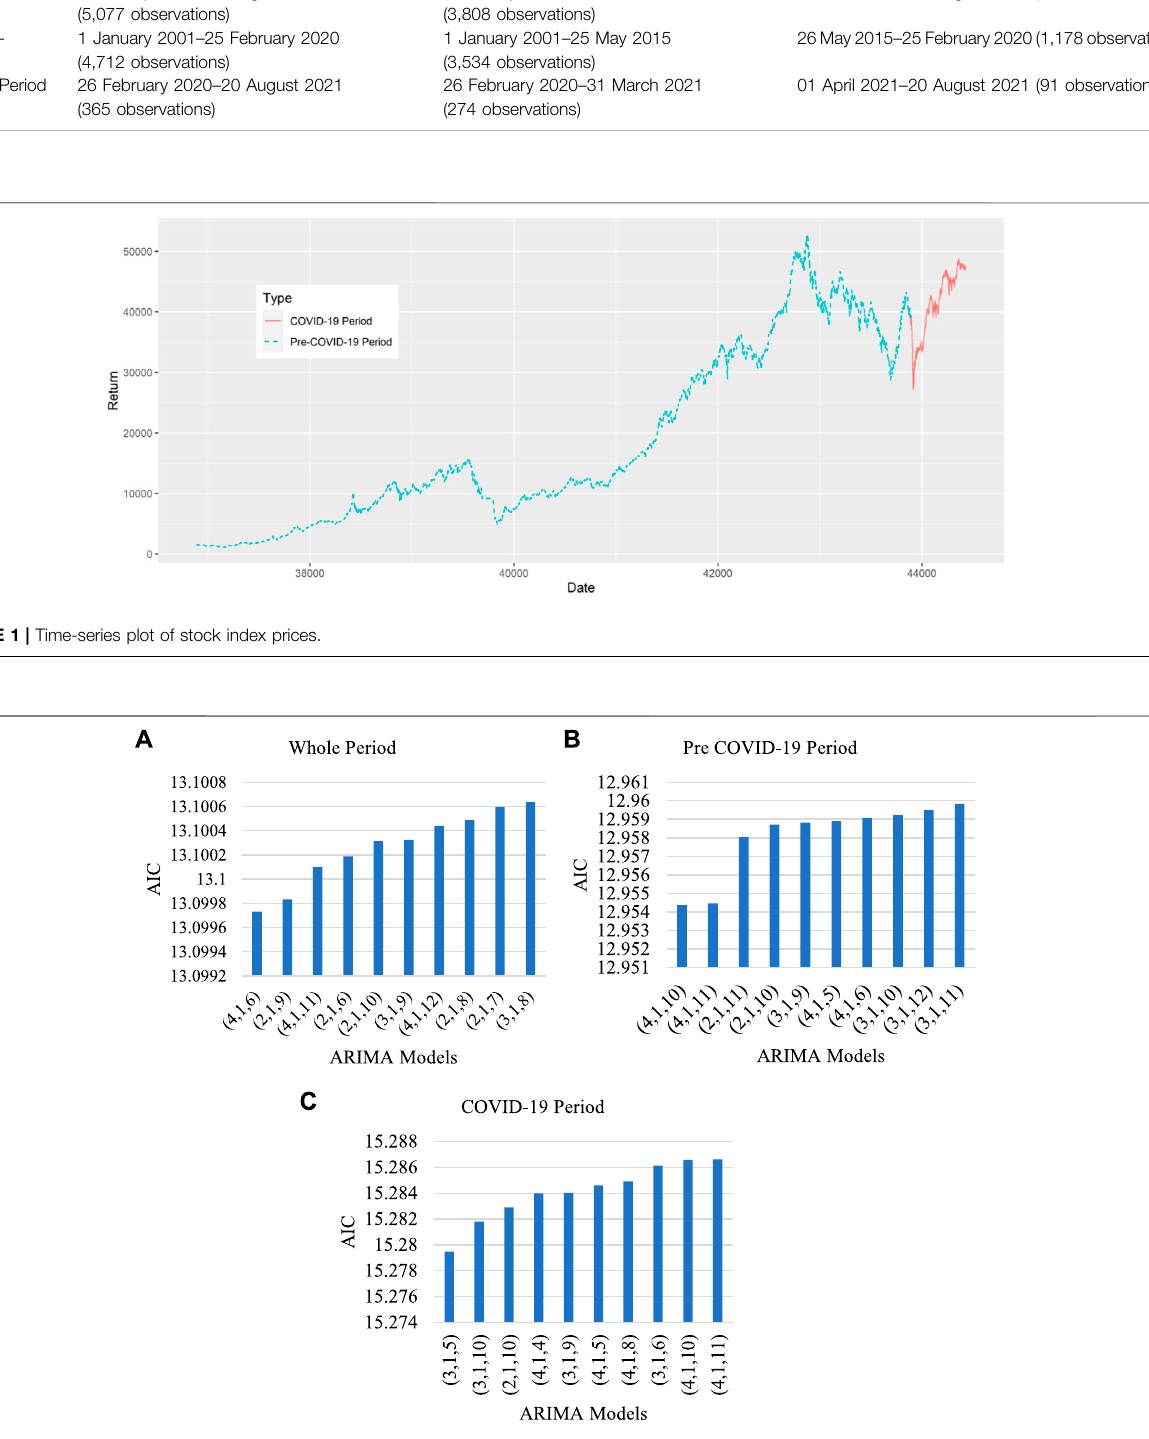
FIGURE 2 | Comparison of different orders of ARIMA models for stock indices based on AIC on different time frames; i.e., (A) whole period, (B) pre-Covid- 19 period, and (C) Covid-19 period.